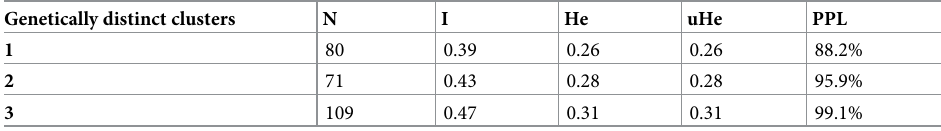
109 0.47 0.31 0.31 99.1% “N” for number of observations, “I” for Shannon’s information index, “He” for expected heterozygosity, “uHe” for unbiased heterozygosity, and “PPL” for percentage of polymorphic